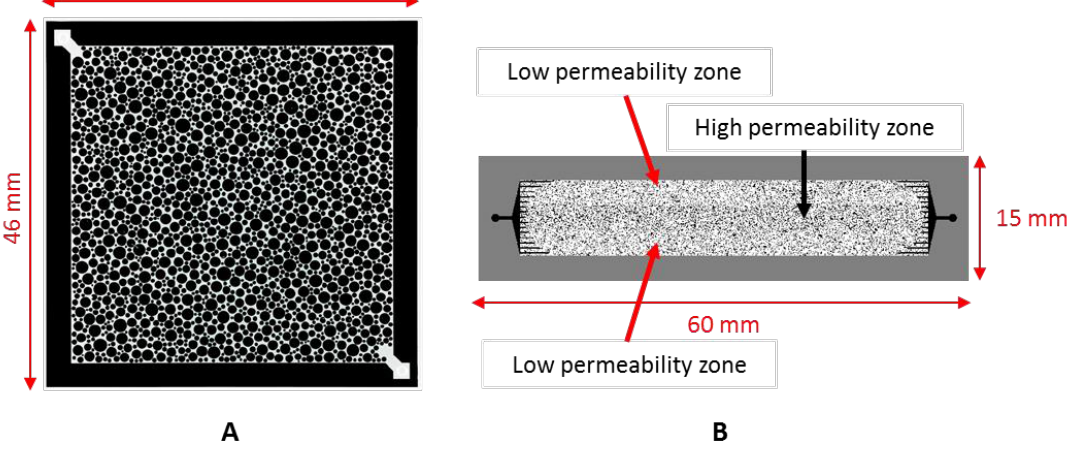
Figure 3. Micromodels used in this study. ( A ) artificial-structure ( B ) real-structure micromodel [40]. Table 3. Porous Media characteristics of micromodels used in this Table 3. Porous Media characteristics of micromodels used in this work.